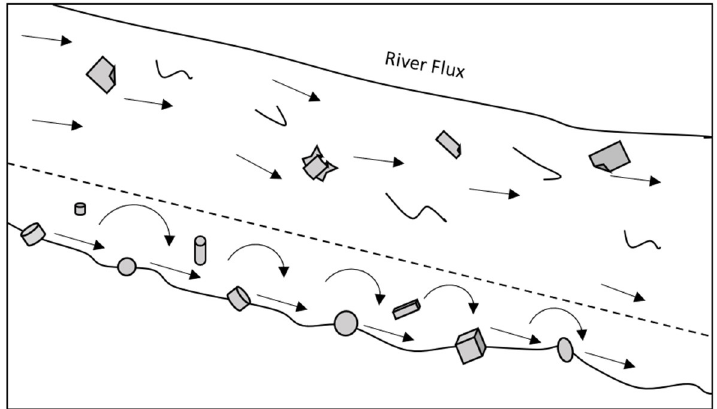
Figure 4. Three-dimensional particles migrate preferentially by saltation or dragging movement. Mono and bidimensional particles migrate preferentially by suspension movement, through river flow.